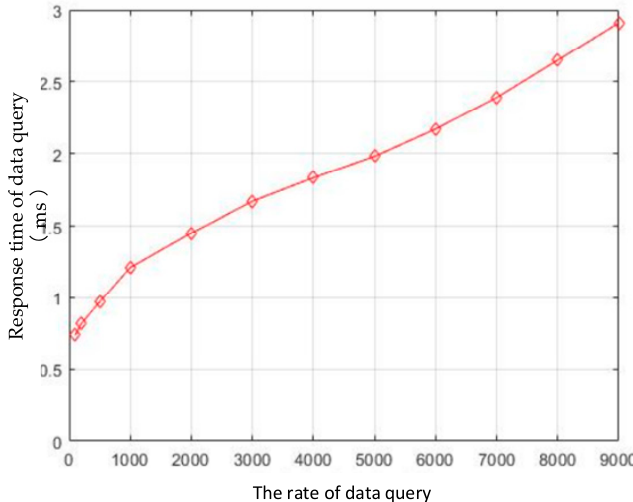
Figure 14. Response time of product data query.